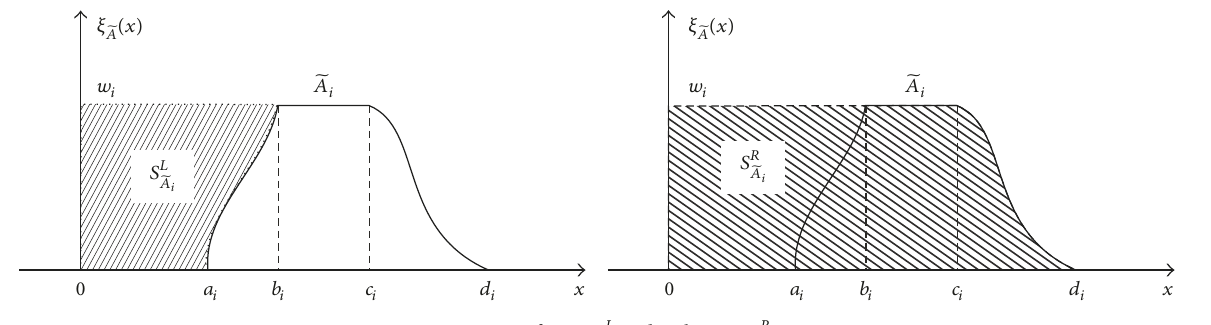
Figure 2: Left area 𝑆 𝐿 𝑖 and right area 𝑆 𝑅 𝑖